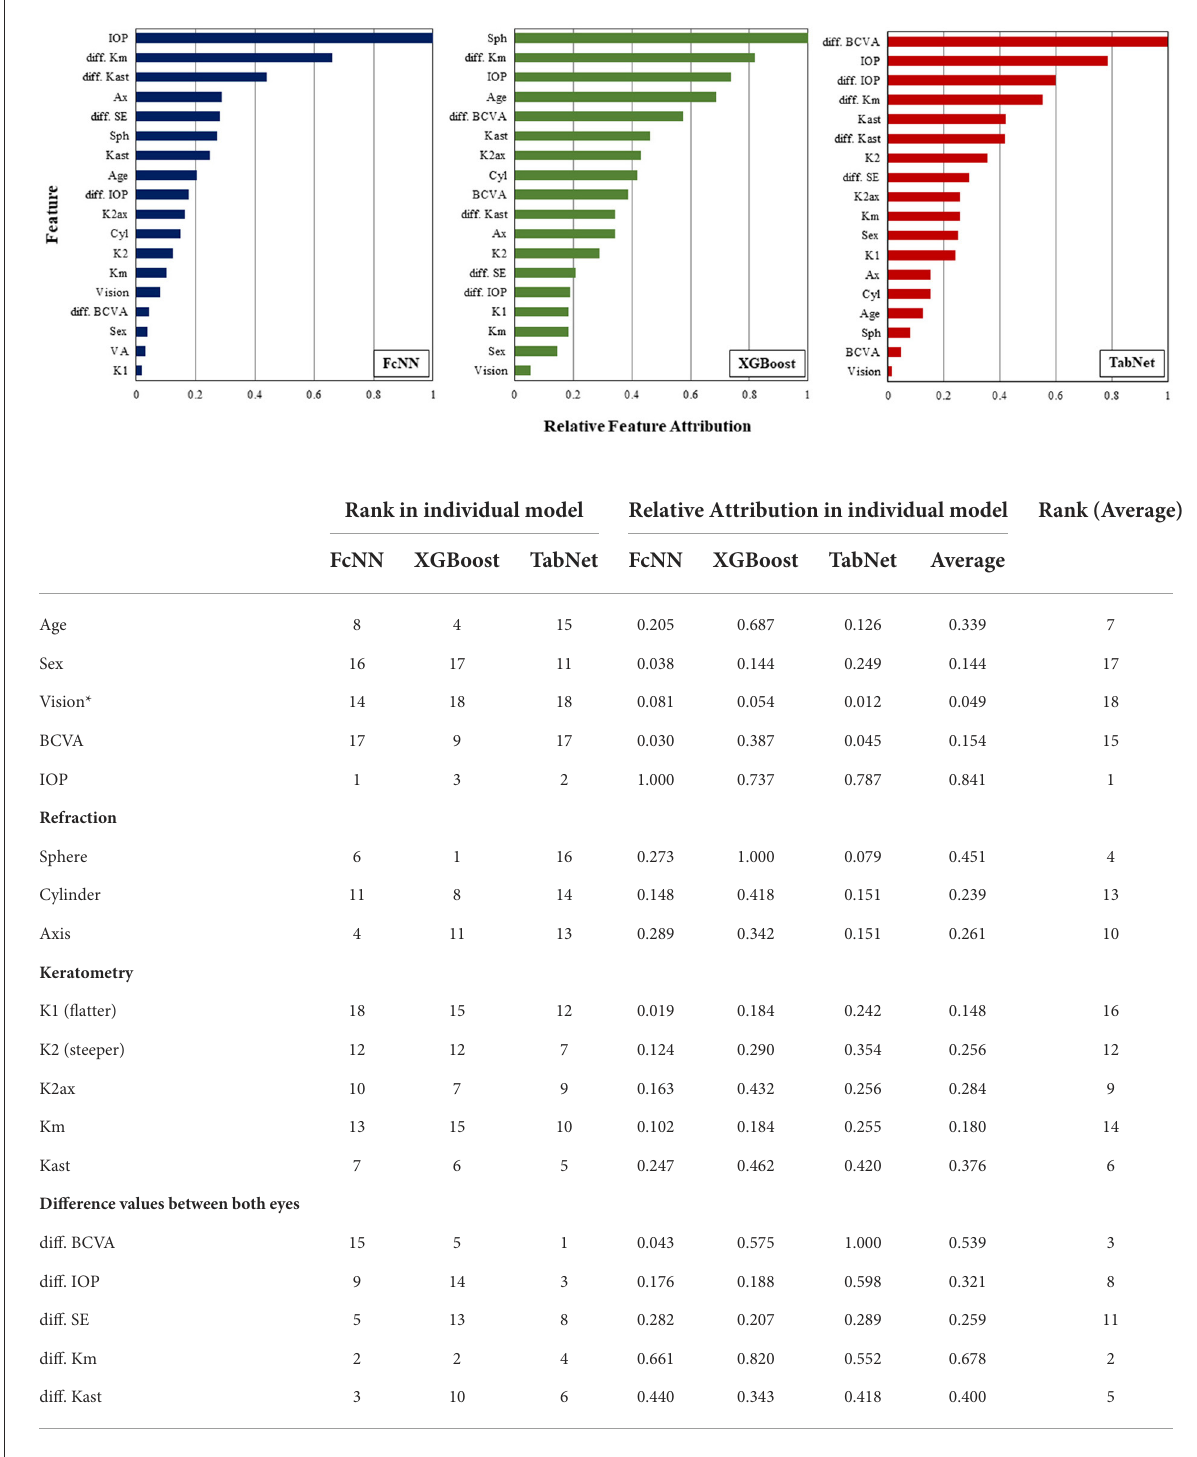
FIGURE3 The explainable interpretation of feature importances in the individual AI models. * Symptoms as progressive, consistent, and/or uncorrected visual impairment. BCVA, best-corrected visual acuity; IOP, intra-ocular pressure; Km, mean value of corneal power; Kast, corneal astigmatism; SE, spherical